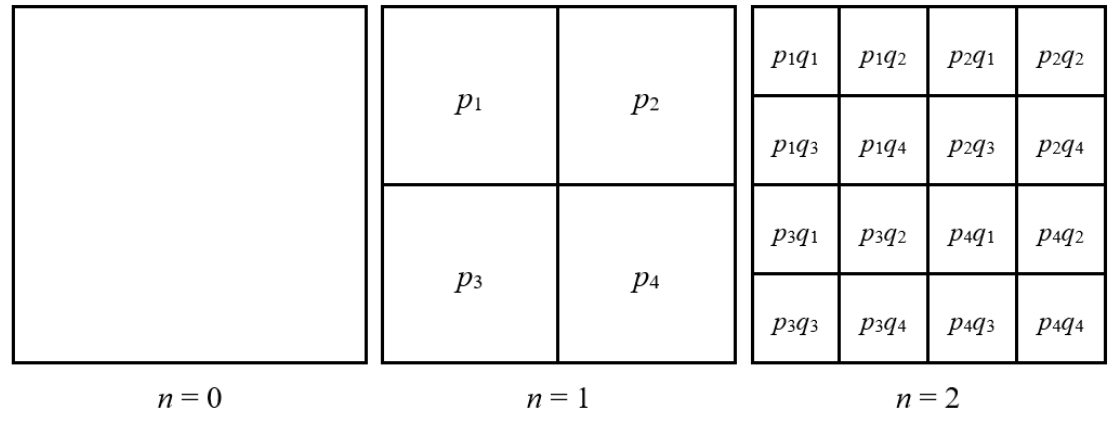
Figure 2. Schematic of the multiplicative cascades for a two-dimensional case.